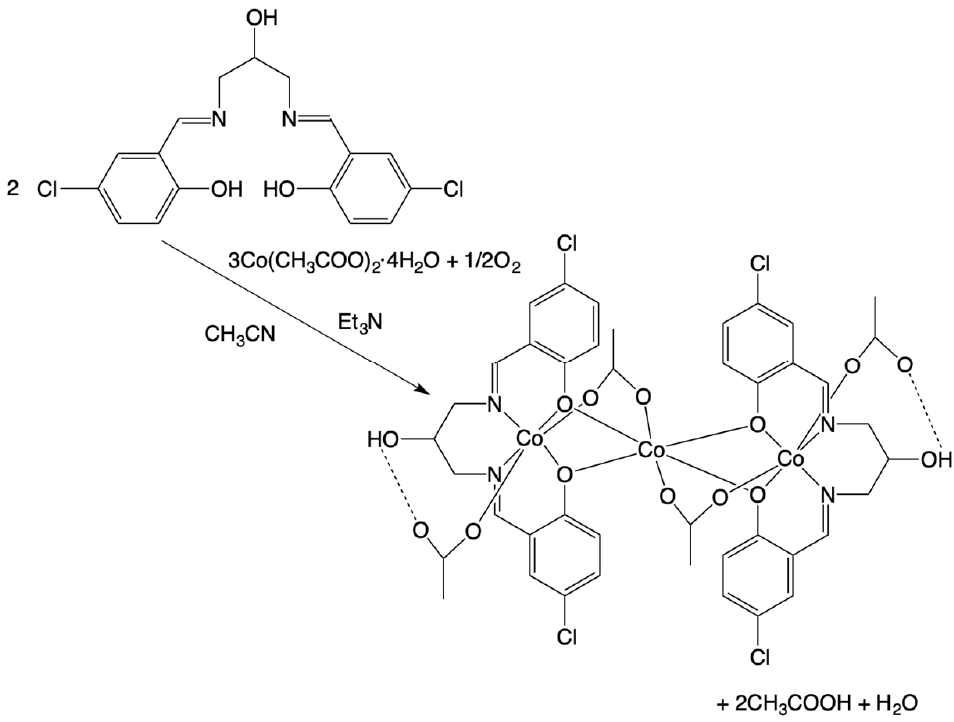
Figure 3. Synthetic scheme of the trinuclear cobalt complex [Co 3 (Hclsalpr) 2 (CH 3 COO) 4 ].